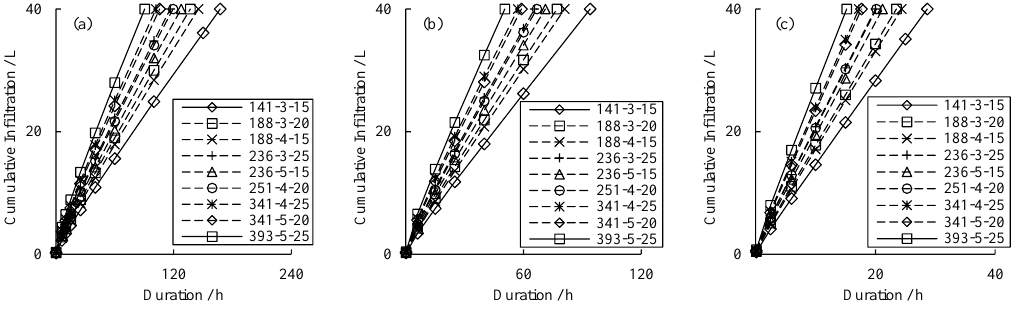
Figure 4. Effect of tube seepage area, diameter and length on vertical line source irrigation. In the legend, the first values are the seepage area ( S a ), cm 2 , the second values are the diameter ( D ), cm, and the third values are the length ( L ), cm. (a) silt loam; (b) loam; and (c) sandy loam.